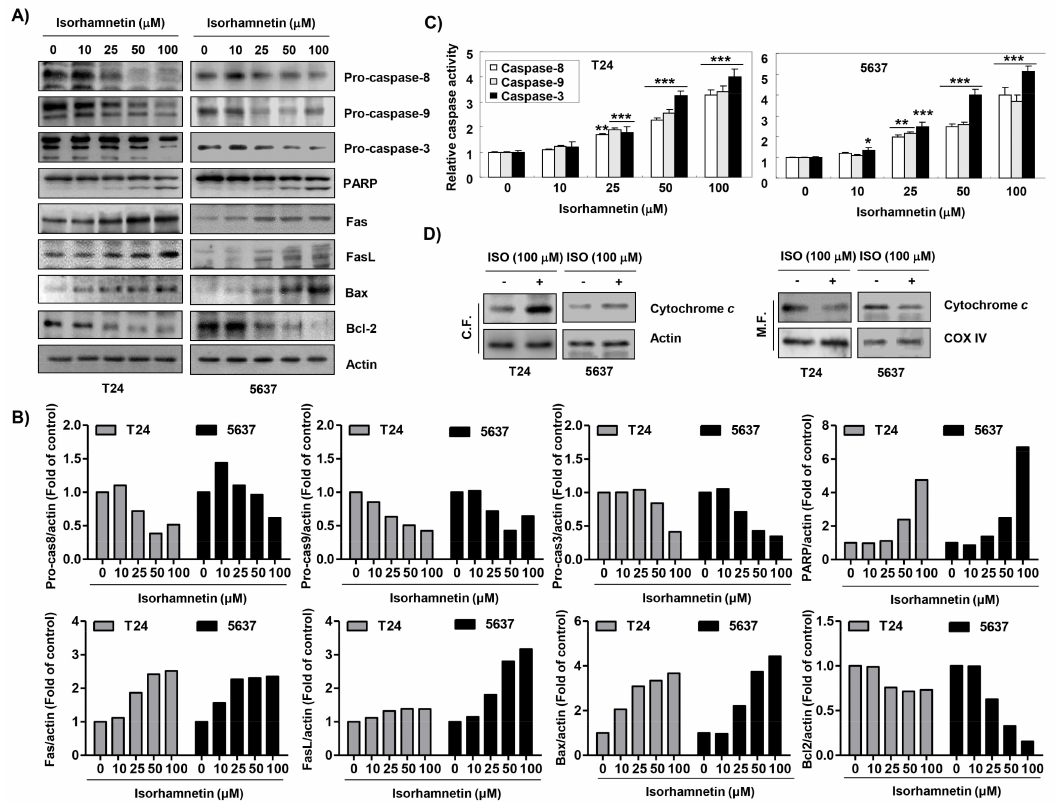
Figure 4. Modulation of apoptosis-regulatory factors using isorhamnetin in bladder cancer cells. ( A ) After treatment with isorhamnetin for 48 h, Western blotting was performed using the indicated antibodies and an ECL detection system. Actin was used as an internal control. ( B ) The expression of each protein was indicated as a fold change relative to the control. Quantitative analysis of mean pixel density was performed using the ImageJ ® software. ( C ) The activities of caspases were evaluated using caspase colorimetric assay kits. The data were expressed as the mean ± SD of three independent experiments (* p < 0.05, ** p < 0.001, and *** p < 0.0001 compared to the control). ( D ) After treatment without or with 100 µ M isorhamnetin for 48 h, cytosolic and mitochondrial proteins were prepared and analyzed for cytochrome c expression using Western blot analysis. Equal protein loading was confirmed via the analysis of actin and cytochrome oxidase subunit VI (COX VI) in each protein extract (C.F.—cytosolic fraction; M.F.—mitochondrial